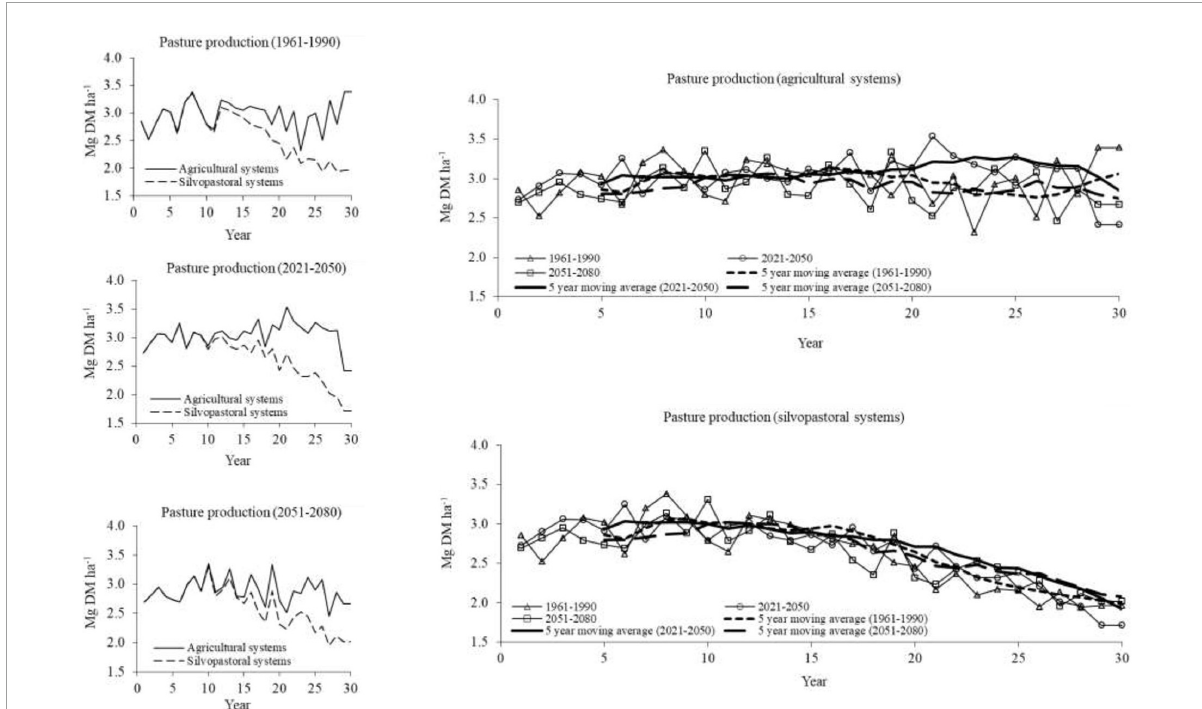
FIGURE5 Pasture production ( Dactylis glomerata ) [mg dry matter (DM) ha - 1 ] simulated with the Yield-SAFE model in hypothetical agricultural and silvopastoral systems under different scenarios of climate established through the CliPick tool (Palma, 2017): (i) climate from 1961 to 1990, (ii) climate from 2021 to 2050, and (iii) climate from 2051 to